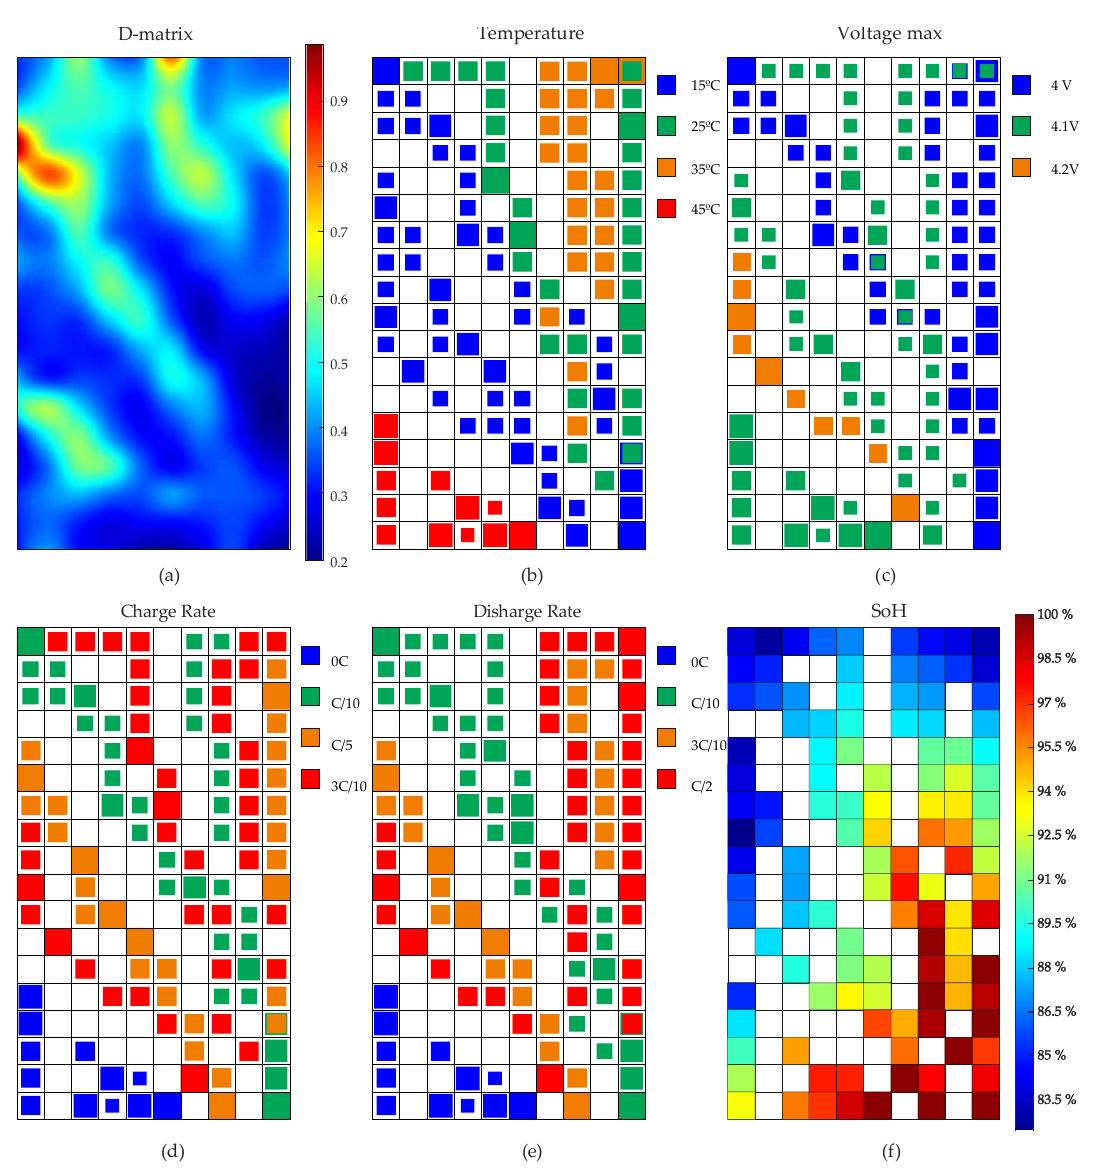
Figure 11. White neurons are those that never have been BMU (interpolating neurons), small colored squares indicate that a neuron has been BMU once or a few times, large colored squares indicate that a neuron has been BMU many times. ( a ) D ‐ matrix (smoothed), ( b ) Temperature map distribution, ( c ) Maximum charge voltage map, ( d ) Charge rate distribution, ( e ) Discharge rate distribution, ( f ) SoH distribution.